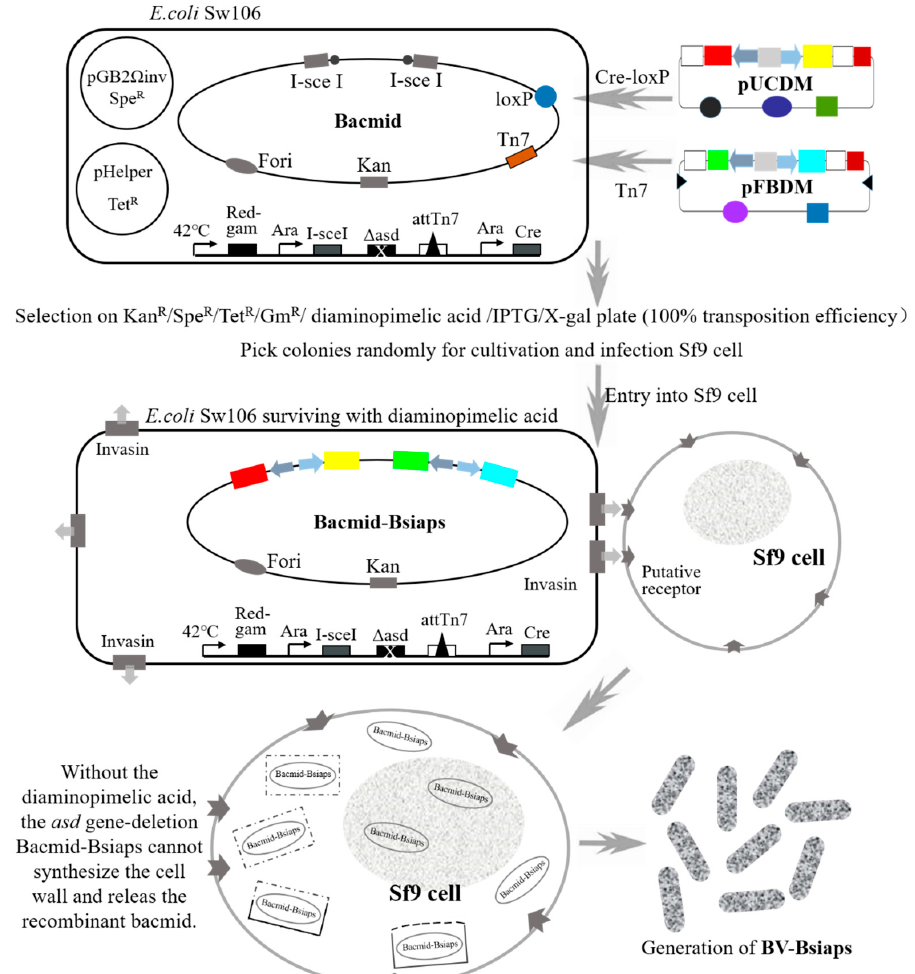
Figure 3. Schematic illustrating the construction of recombinant BV-Bsiaps baculovirus through multi-gene co-expression and liposome-free transfection technology. Bsiap genes carried by the recombinant plasmids, pFBDM and pUCDM, were introduced into an E. coli Sw106 bacmid using Tn7 and Cre-loxP sites, respectively. Due to the lack of diaminopimelic acid in Sf9 cells, E. coli Sw106, which invade Sf9 cells via invasin activity, cannot synthesize cell walls, and bacmids are released and BV-Bsiaps proliferation completed.